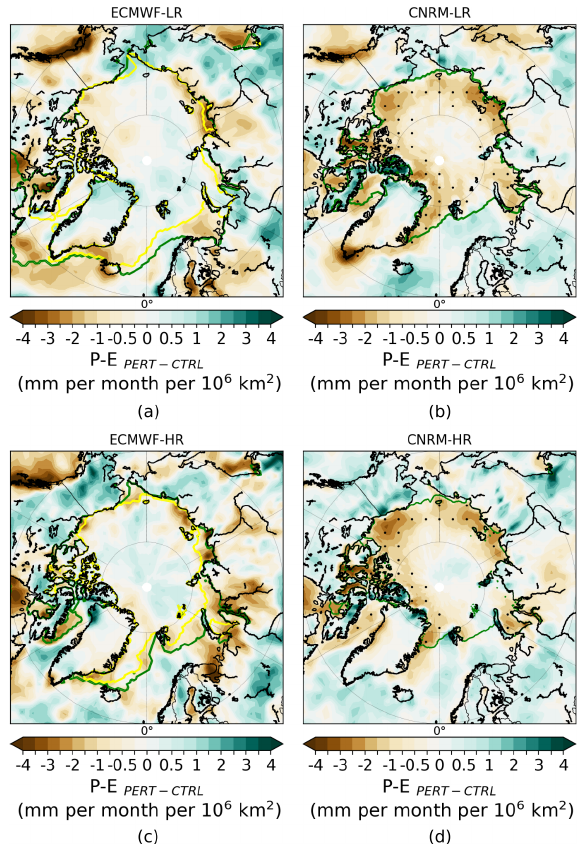
Figure A5. Ensemble mean changes (PERT − CTRL) in sum- mer (JAS) precipitation minus evaporation ( P – E ) scaled by the amount of sea ice extent loss for ECMWF-LR (a) , CNRM-LR (b) , ECMWF-HR (c) and CNRM-HR (d) . The dots show where the re- sponse is statistically significant according to a 10% level FDR test associated with a Kolmogorov–Smirnov test. The green and yellow lines represent the sea ice edge (15% ice concentration) from CTRL and PERT,